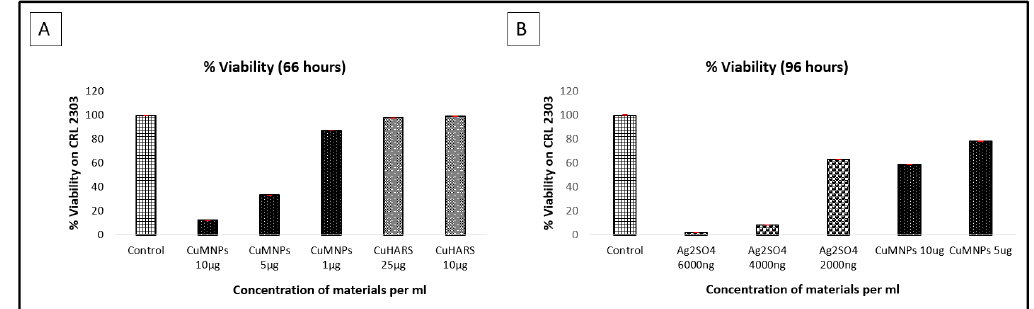
Figure 10. Toxicity testing of free metals added on incubated cells. CRL 2303 glioma cells at 40,000 per well were treated with unoxidized copper nanoparticles (CuMNPs) and CuHARS (Panel A ), and at the indicated concentrations of Ag 2 SO 4 and CuMNPs (Panel B ) and tested for viability. CRL 2303 cells at 40,000 per well were grown in vitro for two days and three days respectively as shown in panel A and B and then treated with either CuMNPs and CuHARS (Panel A ), or Ag 2 SO 4 (Panel B ). Upon termination after 18 h (Panel A ) and 24 h (Panel B ) post treatment, respectively, an MTT assay was carried out to test for cellular metabolic activity. Data for each condition are the average of n = 2 wells, representing multiple plates from multiple platings of cells. Y -axis = viability normalized to % of controls (column 1 values). Controls were the untreated cells in both panels.